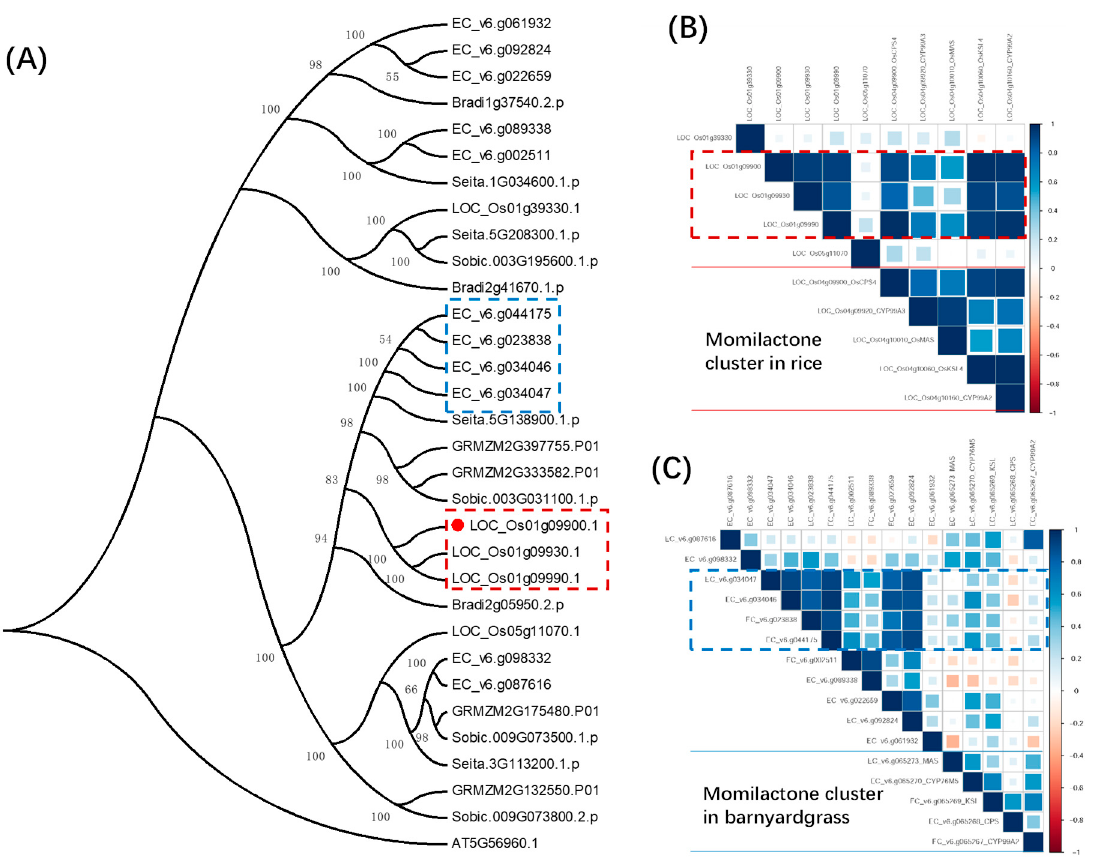
Figure 4. Co-expression pattern between genes in the momilactone cluster and transcription factor DPFs. ( A ) Phylogenetic tree for rice diterpenoid phytoalexin factor (DPF) and its homologous genes. The rice DPF ( LOC_Os01g09900 ) gene is highlighted with red dot, while its paralogs is highlighted with red dashed frame. The orthologous DPFs in E. crus-galli are highlighted in the blue dot box. ( B ) The co-expression coefficient matrix for genes in the momilactone cluster and DPFs in rice. The rice DPF genes regulating the rice BGCs are highlighted with red dot box. ( C ) The co-expression coefficient matrix for genes in the predicted momilactone cluster and DPF homologs in barnyardgrass.